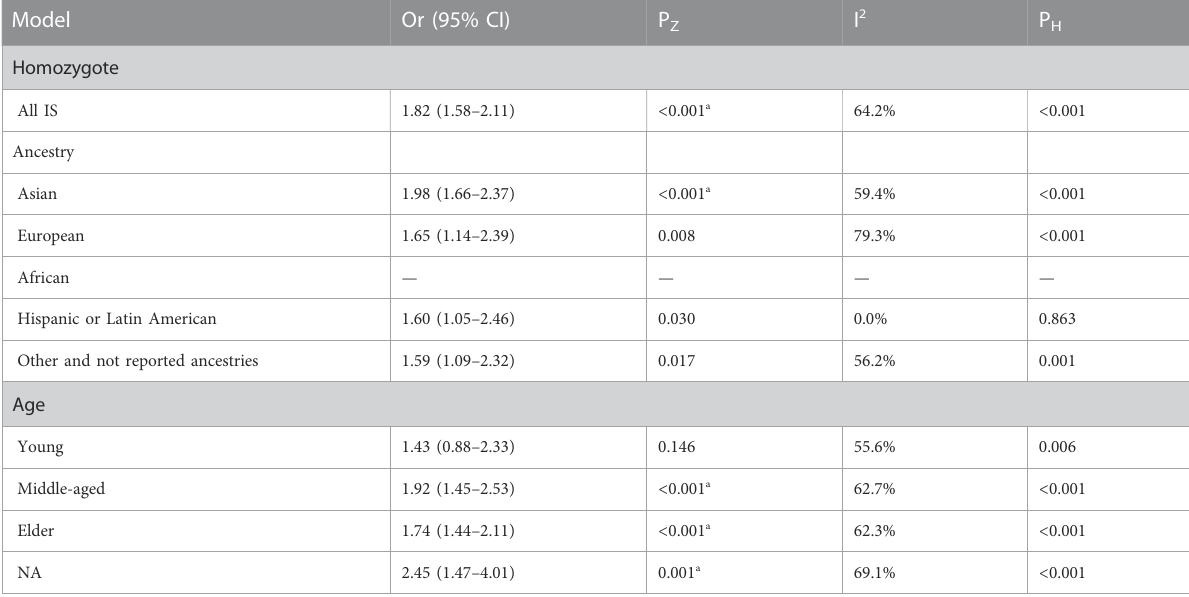
TABLE 5 Pooled odds ratios (ORs) and 95% con fi dence intervals (CIs) of the association between C677T polymorphism and stroke in the homozygous model.